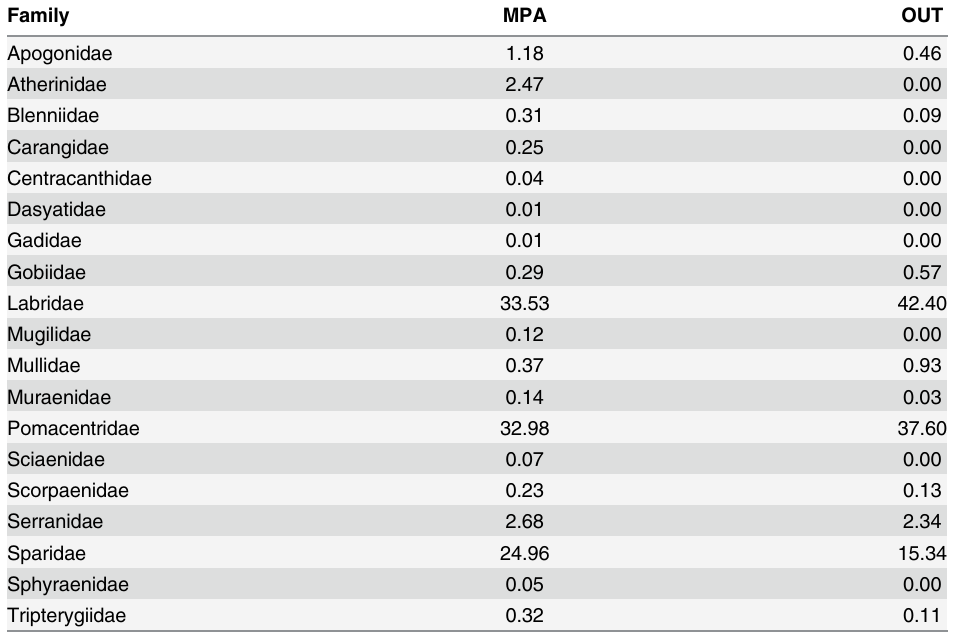
Table 3. Percentages of abundance of the fish families in the assemblages inside and outside the Sinis MPA. Family MPA OUT Apogonidae 1.18 0.46 Atherinidae 2.47 0.00